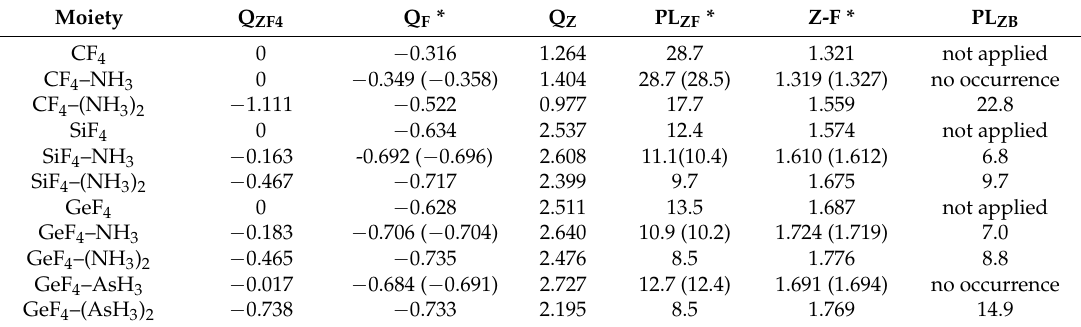
Table 3. The NBO characteristics; charges (in au) and polarizations (percentage of the electron density at Z-centre, Z = C, Si, Ge); and the Z-F bond lengths (Å) are also included. Q ZF4 , the charge of the ZF 4 moiety; Q F , the charge of the F-atom; Q Z , the charge of Z-centre; PL ZF , polarization of the Z-F bond; and PL ZB , polarization of the Z-B (B = N, As)